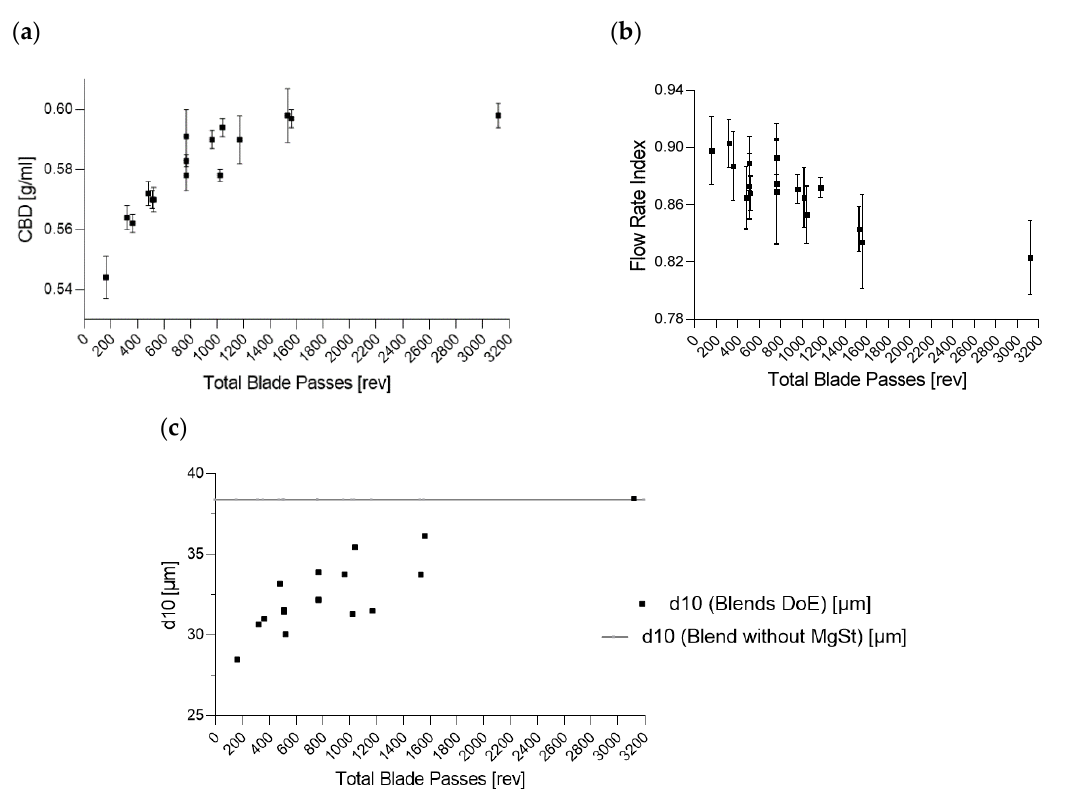
Figure 16. ( a ) Conditioned bulk density (CBD) (g/mL), ( b ) flow rate index (FRI) and ( c ) particle size (d 10 ) (µm) as a function of total blade passes.